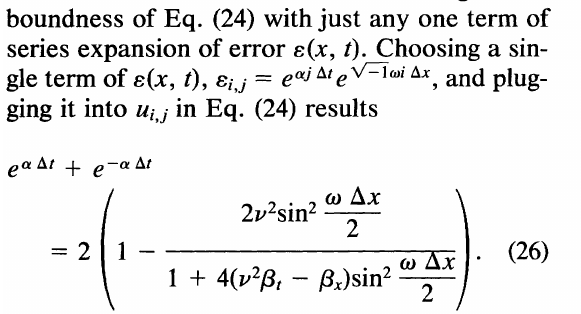
FIGURE 5 Amplification factors and relative phase errors for the proposed